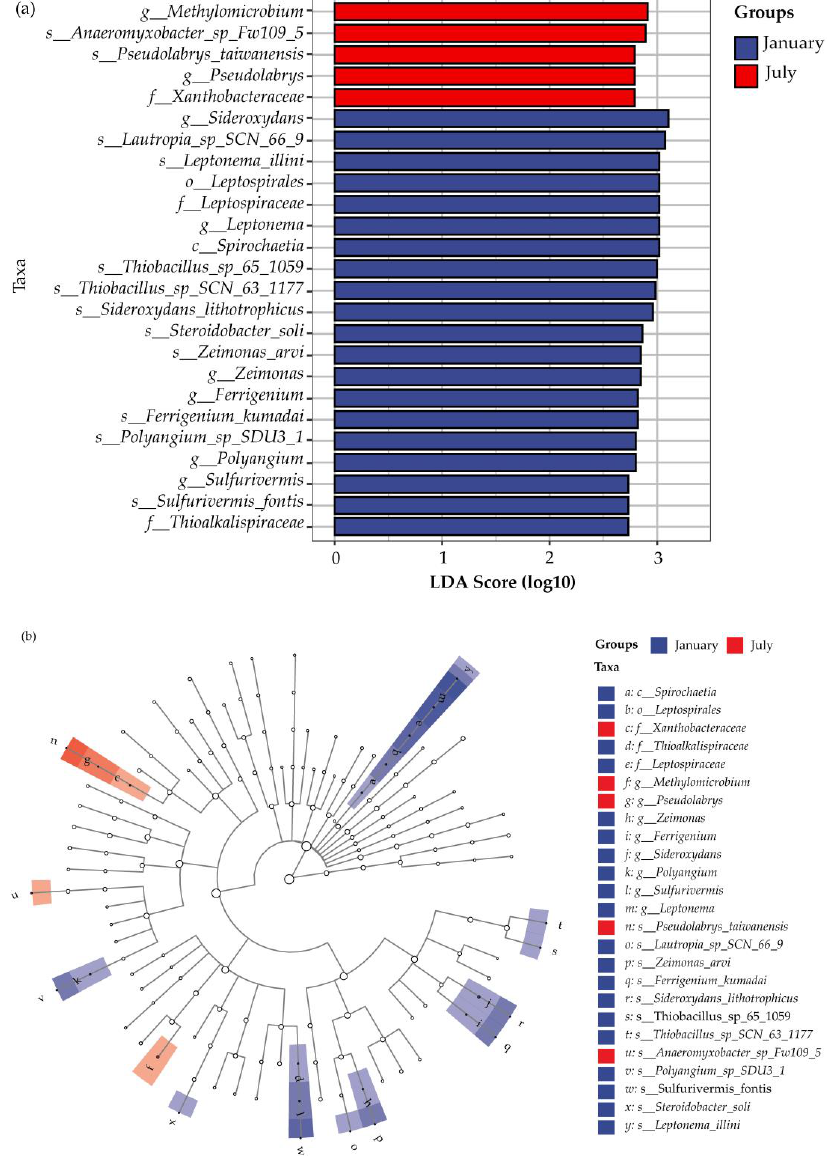
Figure 6. ( a ) LDA distribution map for different species (colors represent groups, and the lengths of the bars represent the contributions of different species). ( b ) Evolutionary branch diagram for different species (circles represent the taxonomic level, from phylum (inner) to species (outer); node size corresponds to species average relative abundance; hollow nodes represent species with no significant differences between groups; significantly different species are colored by group; letters represent the names of significantly different species, which are displayed in the legend).